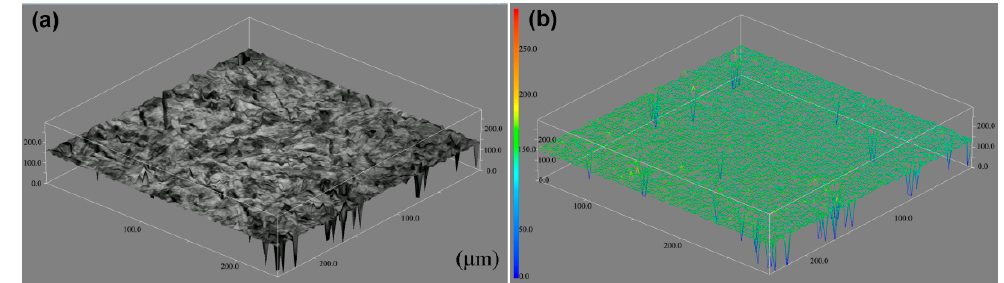
Figure 4. 3D image of sample surface after bainite transformation.